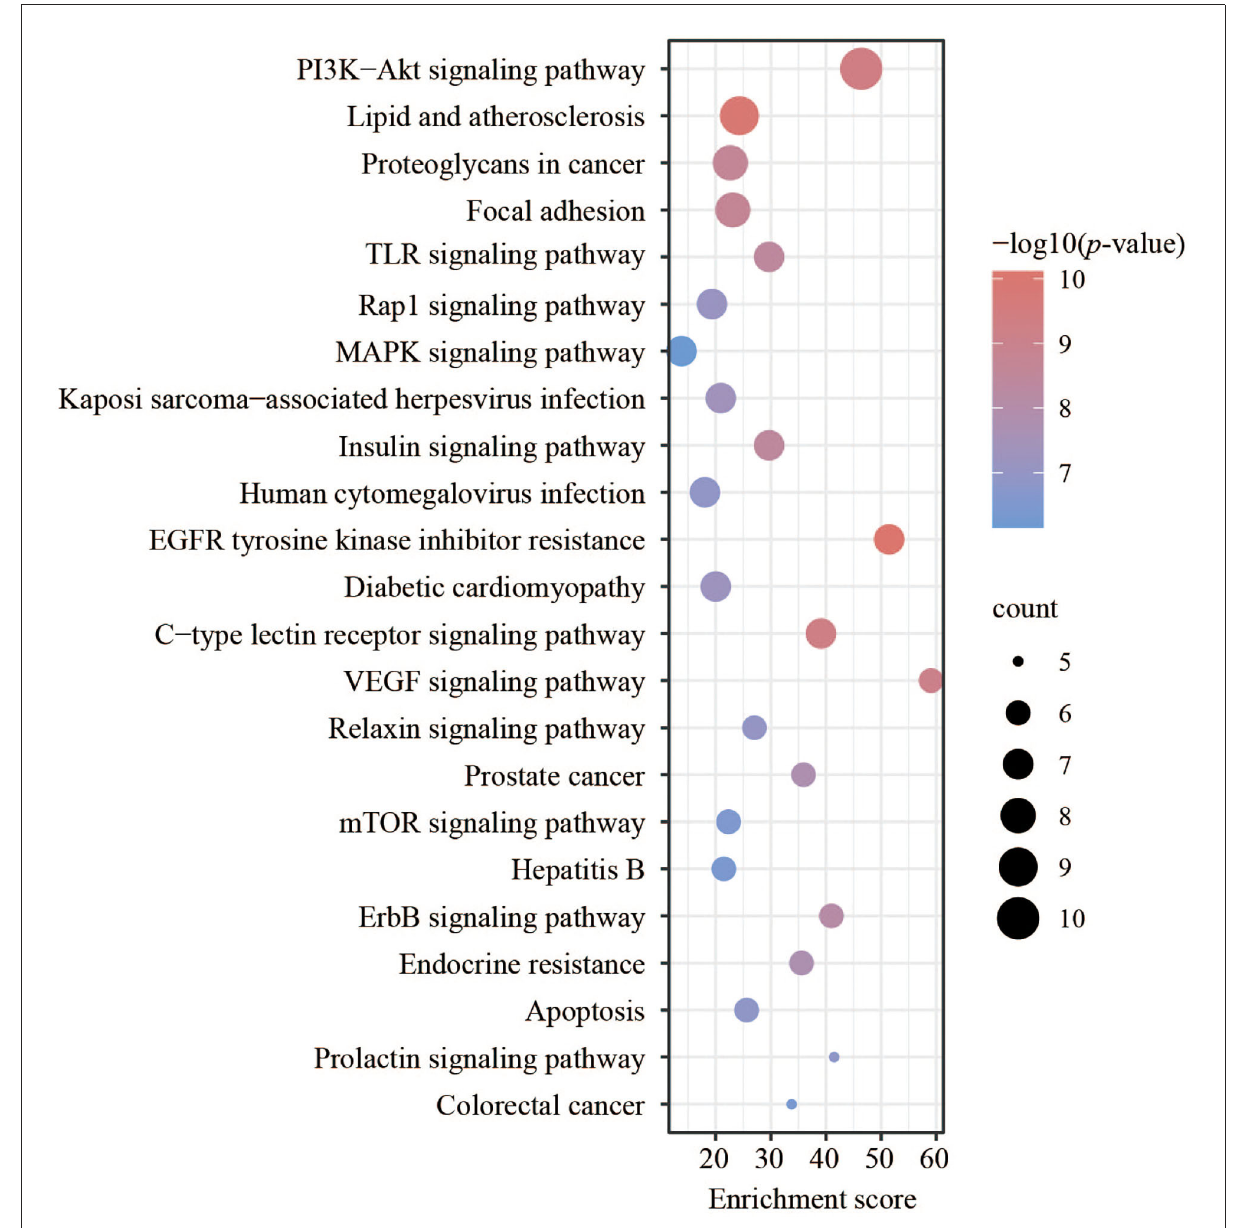
FIGURE5 Kyoto Encyclopedia of Genes and Genomes (KEGG) pathway analysis of key